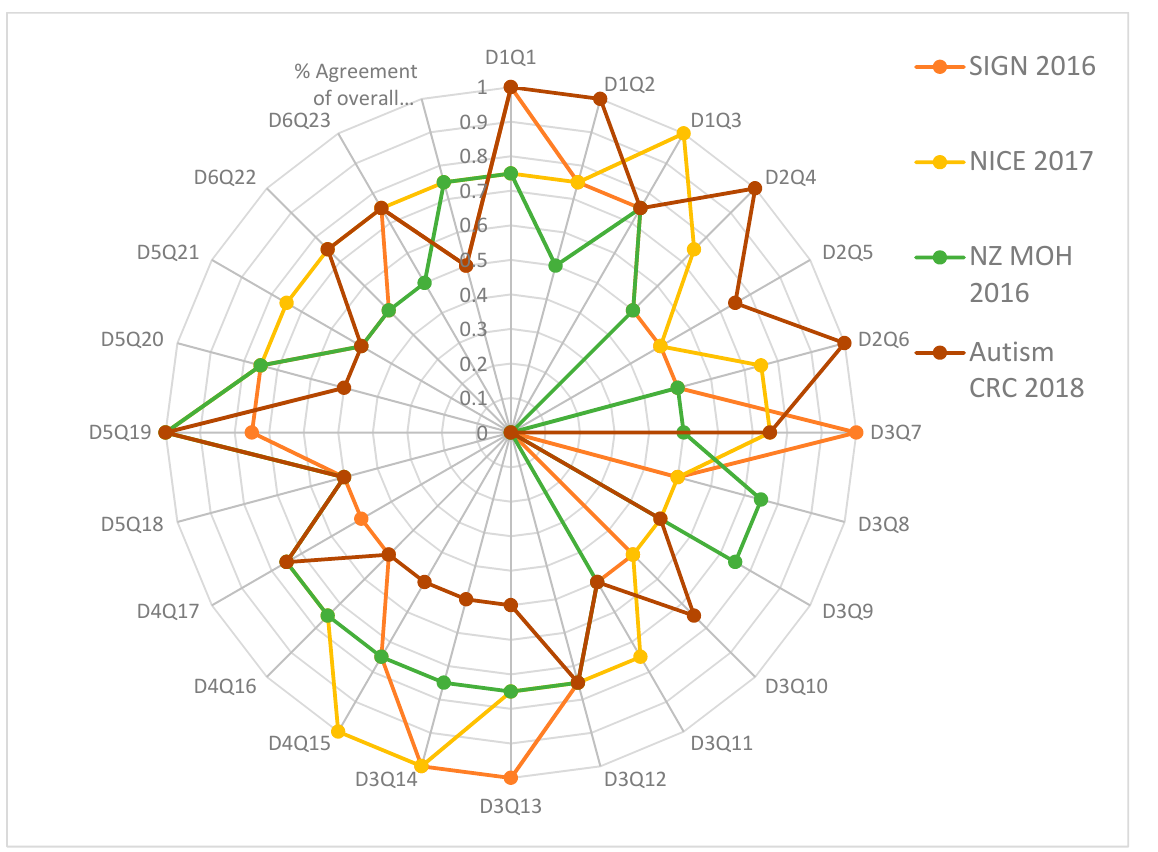
Figure 1. Radar map of the AGREE II final standardized domain scores for eligible appraised ASD CPGs.